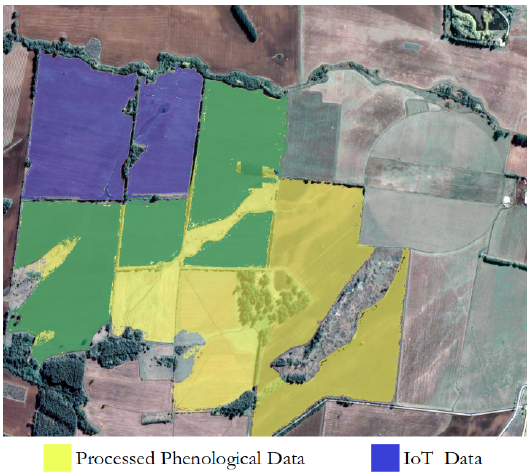
Figure 3. Geographic extension of the datasets shared in the blockchain system– in blue, the IoT raw and processed data, and in yellow, the processed Sentinel-2A